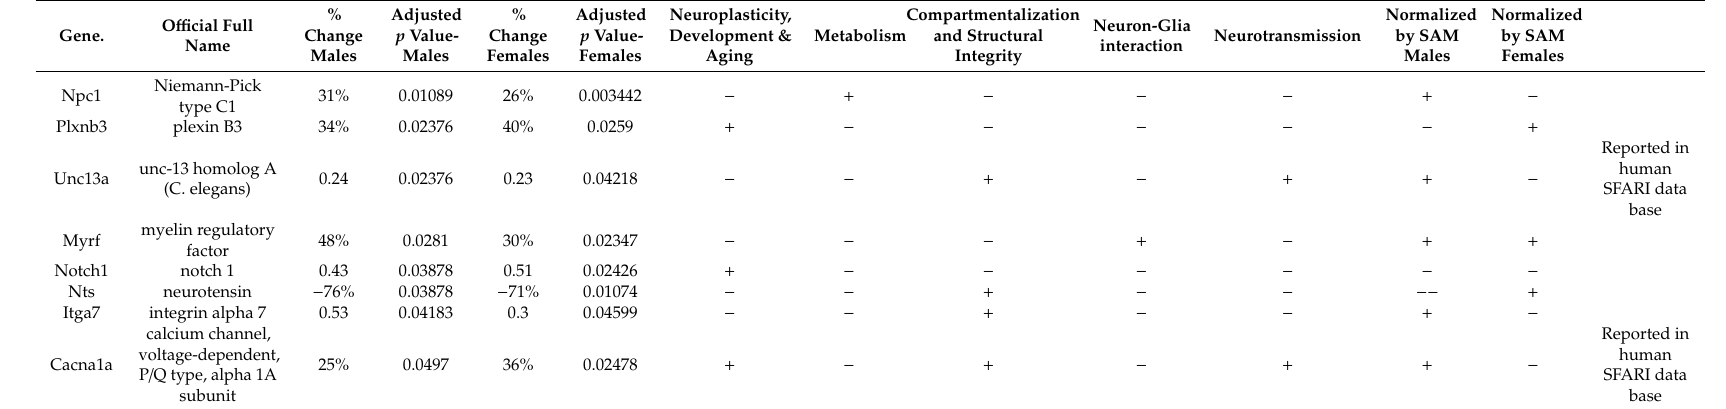
* The genes were ordered by the significance of the adjusted p